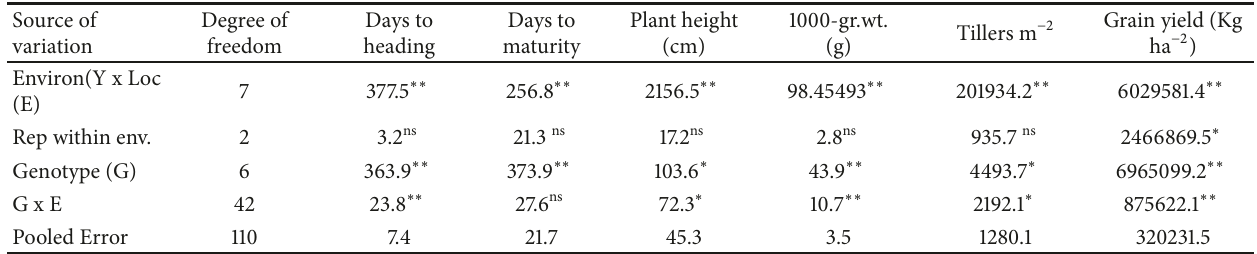
Degree of Days to Days to Plant height 1000-gr.wt. freedom heading maturity (cm)